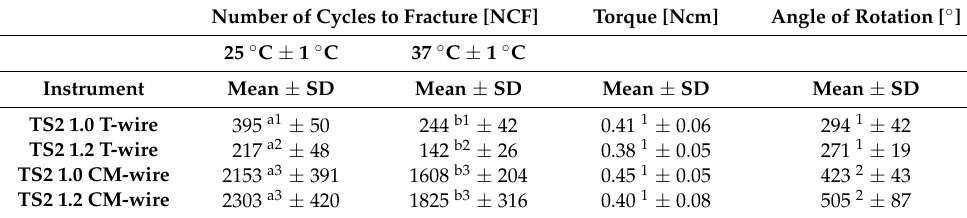
Table 1. Number of cycles to fracture [NCF] at room and body temperature, maximum torque [Ncm], and angle of rotation until fracture [ ◦ ] values [mean ± standard deviation] of the different heat-treated TS2